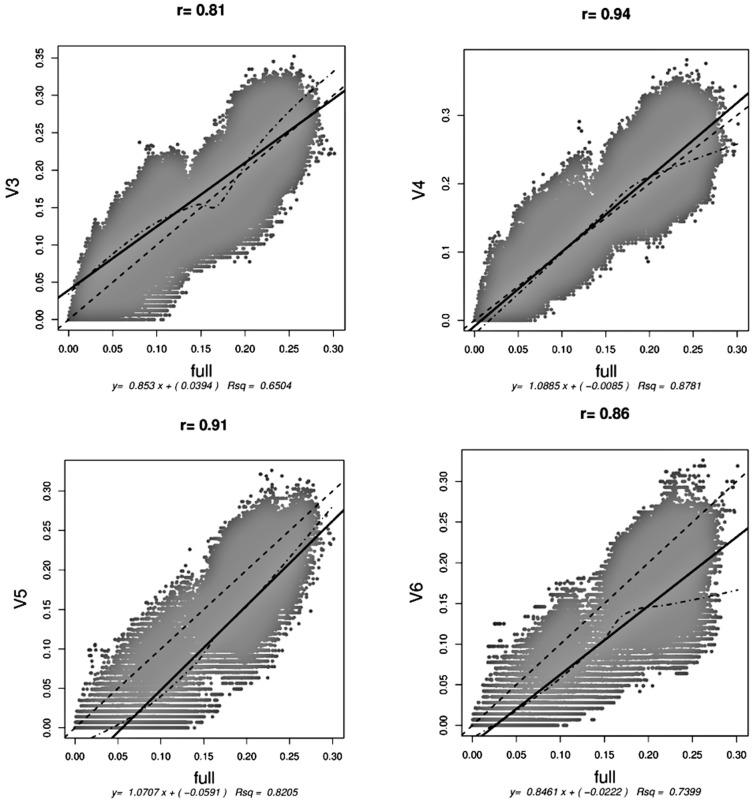
Pearson correlation tests between corresponding sequence distances of examined V regions and FL variants.All tests were significant (P<001). Test correlation index (r) values and linear models (presented with solid lines) used to describe overall trends are provided above and below each plot. Local relationships between corresponding sequence distances of the FL and other datasets are expressed with the non-parametric LOWESS (locally weighted regression and smoothing scatterplots) regression analysis plotting (dot-dashed lines), while the ideal y = x correlation is also plotted (dashed lines).